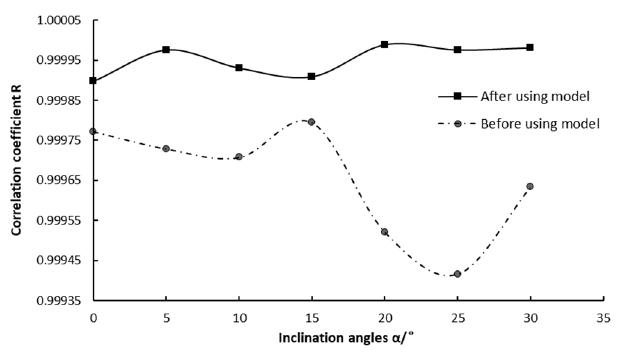
Figure 11. Comparison of wind speed correlation coefficient before and after using the inclination correction model.